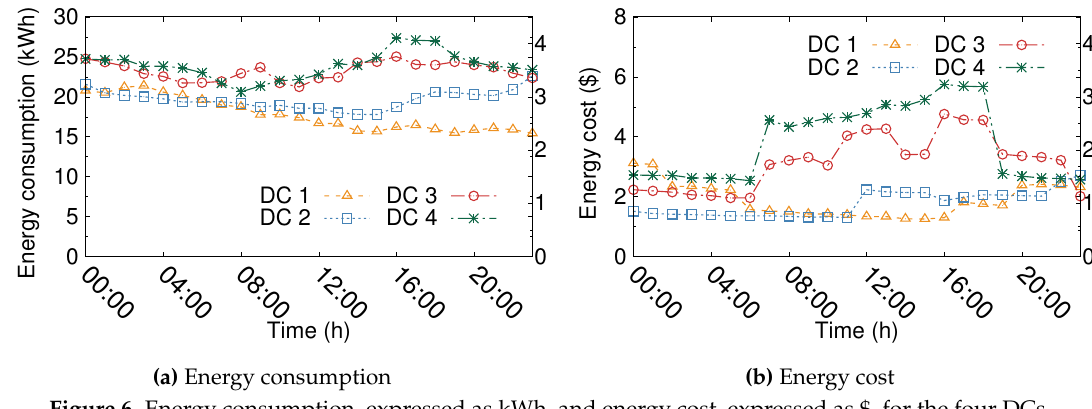
Figure 6. Energy consumption, expressed as kWh, and energy cost, expressed as $, for the four DCs, versus time of the day.